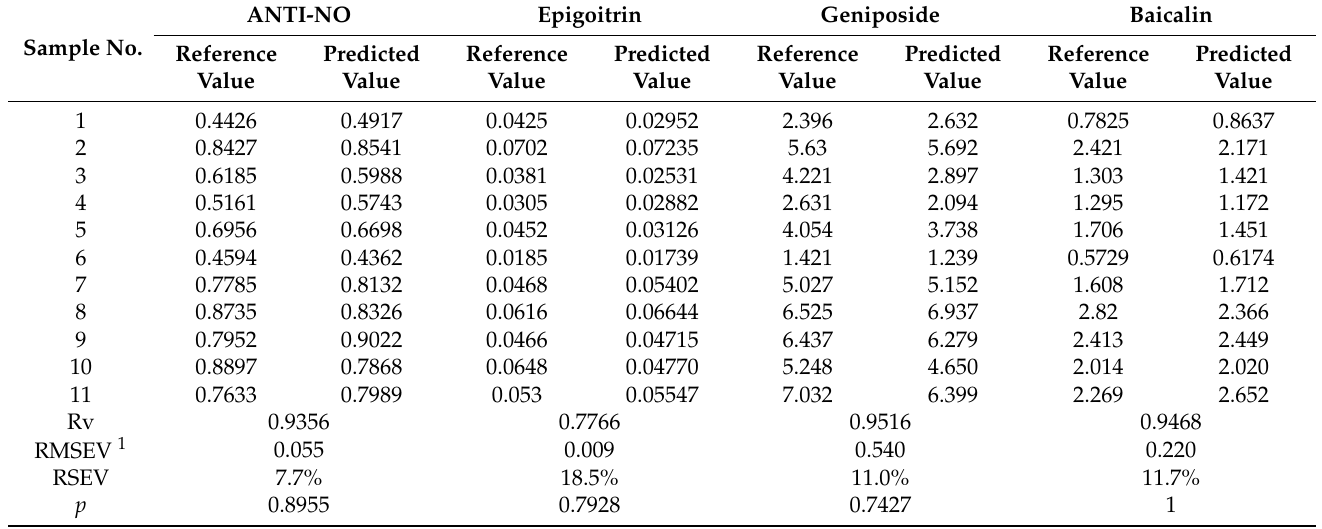
Table 2. The results of external validation of traditional